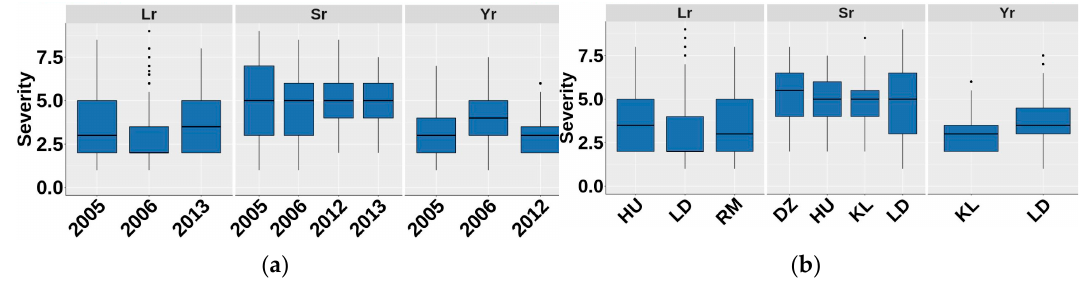
Figure 5. Disease severity scores across: ( a ) years for data collected from sites in that year, and ( b ) sites for data collected across years in that site, where 0 is resistant and 9 is susceptible. Sites are HorseUnit (HU), Lansdowne (LD), Richmond (RM), Debre Zeit (DZ), and Karalee (KL).